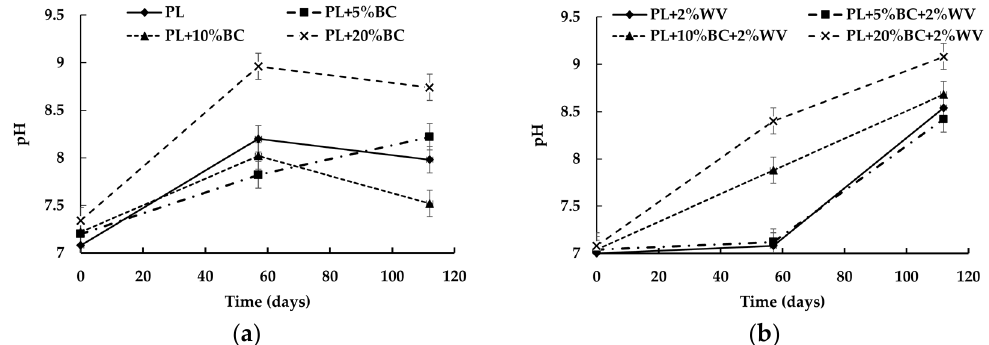
Figure 2. pH values for treatments without WV ( a ) and with WV ( b ) over time. In general, increasing BC level and WV inclusion resulted in higher pH values, with PL + 20% BC + 2% WV having the most alkaline pH at 9.08. PL and PL + 5% BC were not significantly different from each other at Day 112, and WV inclusion did not result in a significant difference in pH for treatments containing 5% and 20% BC. At Day 112, PL + 20% BC + 2% WV was the only WV treatment to have a significantly different pH for WV treatments at Day 112, as PL + 2% WV, PL + 5% BC + 2% WV and PL + 10% BC + 2% WV clustered at an approximate pH of